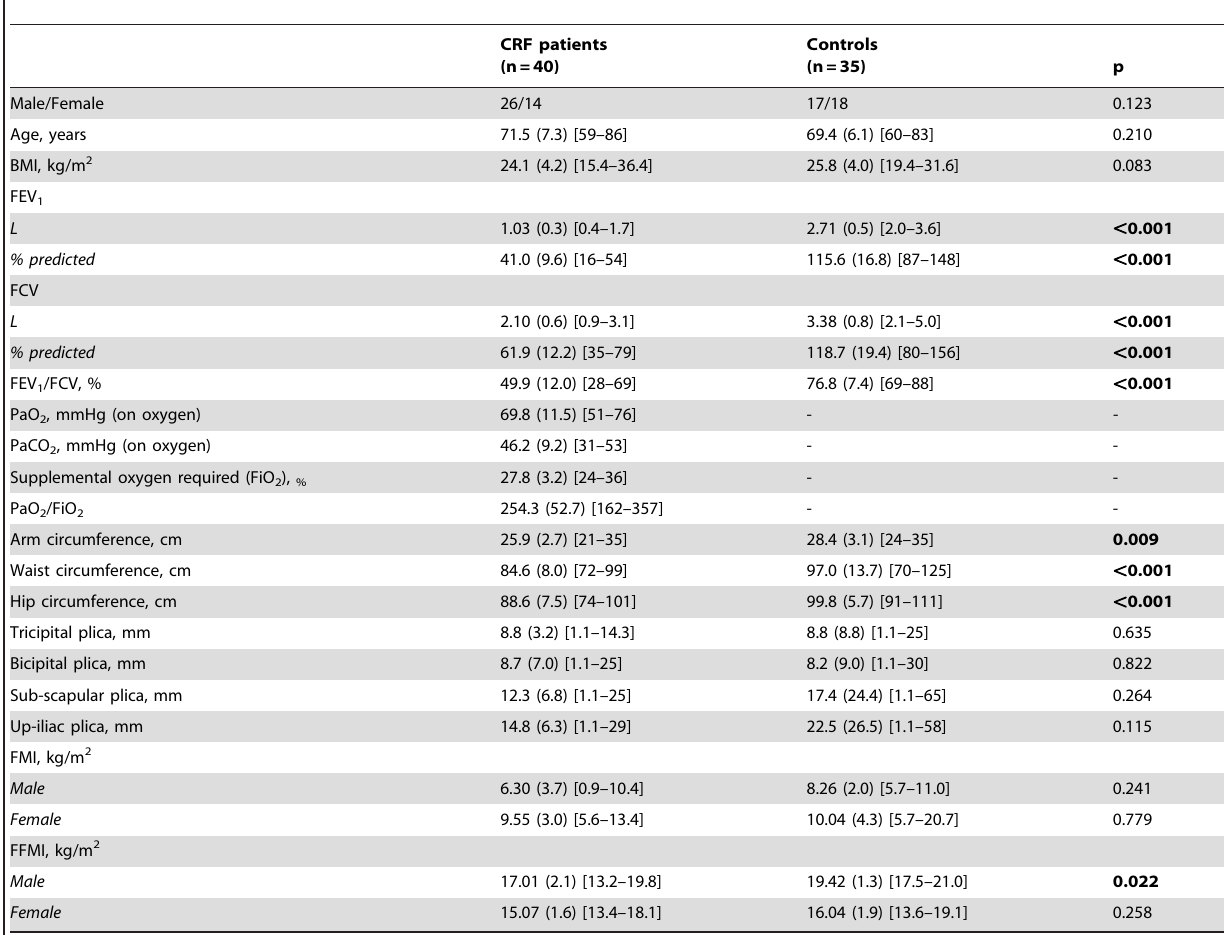
Table 1. General characteristics of the population in